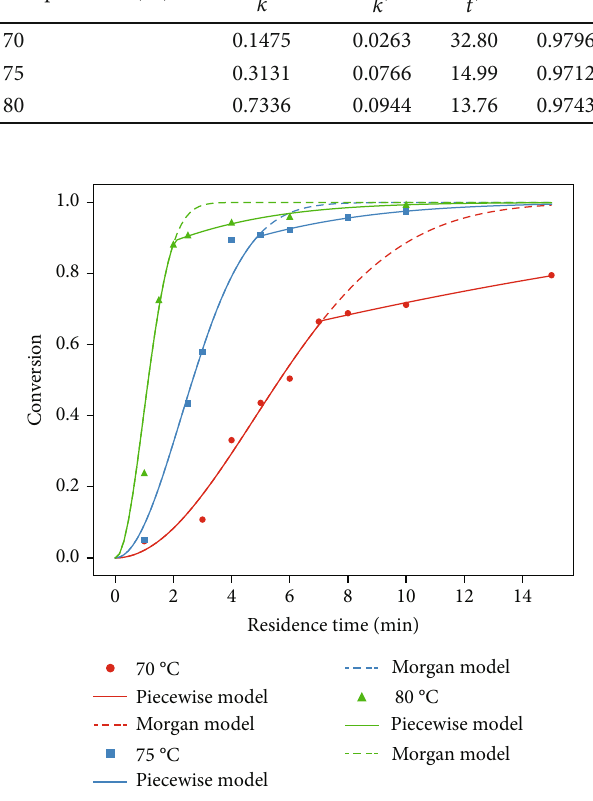
Figure 5: Comparison of the experimental data and the simulated